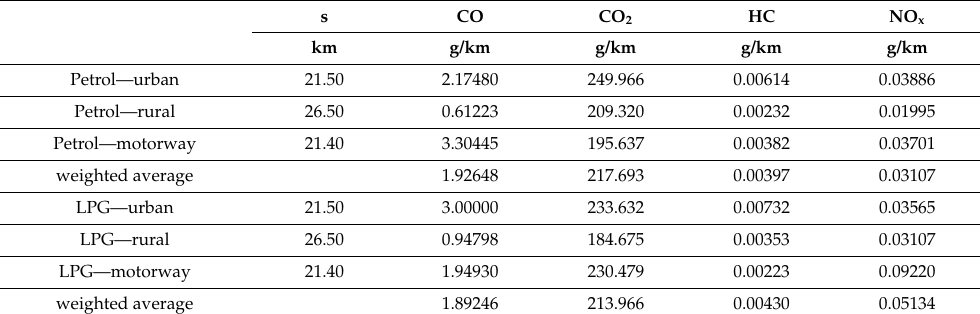
Table 4. Amount of emissions produced [measurement results processed by the author].